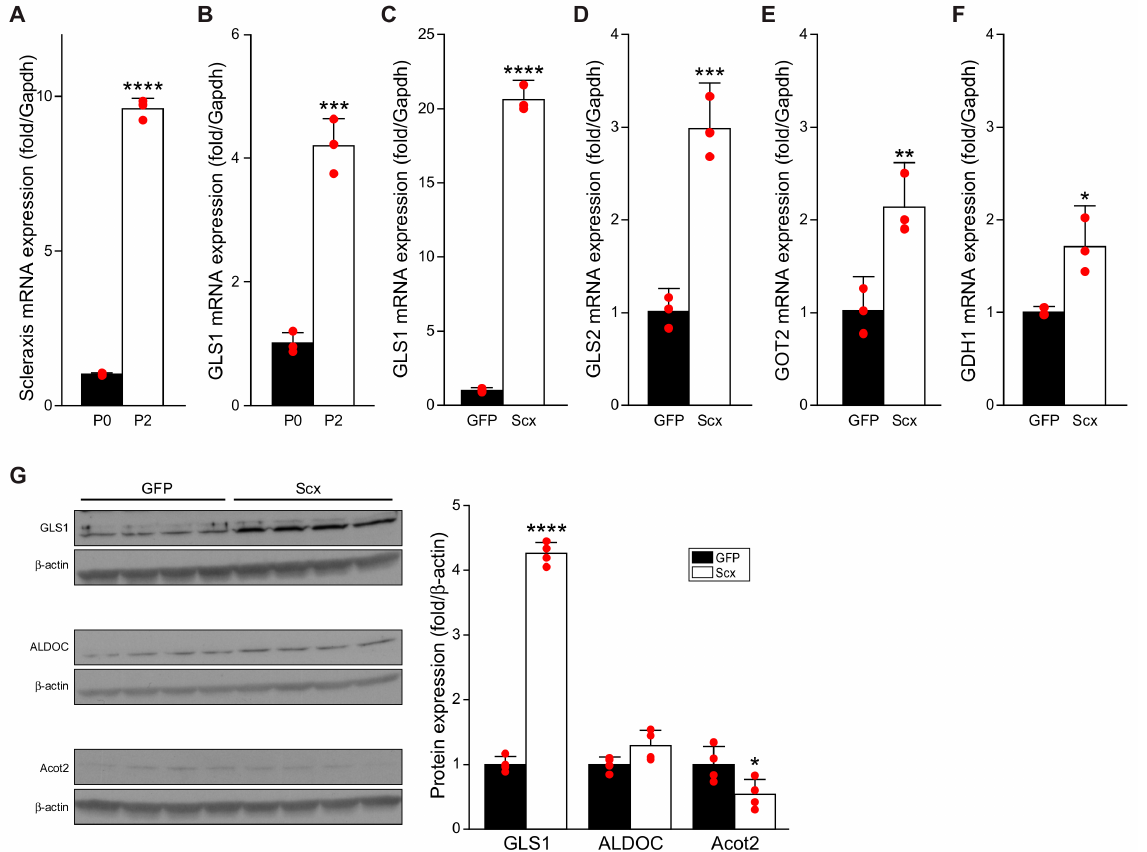
Figure 2. Fibroblast activation and scleraxis overexpression upregulate glutaminolysis gene expres- sion. ( A , B ) Non-passaged (P0), freshly-isolated rat cardiac fibroblasts, or twice-passaged P2 rat cardiac myofibroblasts were assayed for mRNA expression of scleraxis ( A ) and GLS1 ( B ) by qPCR. ( C – G ) P1 rat cardiac fibroblasts were transfected by adenovirus encoding green fluorescent protein (GFP), or scleraxis (Scx) for 48 h, then assayed by qPCR for expression of GLS1 ( C ), GLS2 ( D ), GOT2 ( E ), and GDH1 ( F ), or were analyzed by Western blot for expression of GLS1, ALDOC, and Acot2 ( G ). Statistical analysis was by the two-tailed Student’s t-test (n = 3–4). * p < 0.05, ** p < 0.01, *** p < 0.001, **** p < 0.0001 versus P0 or